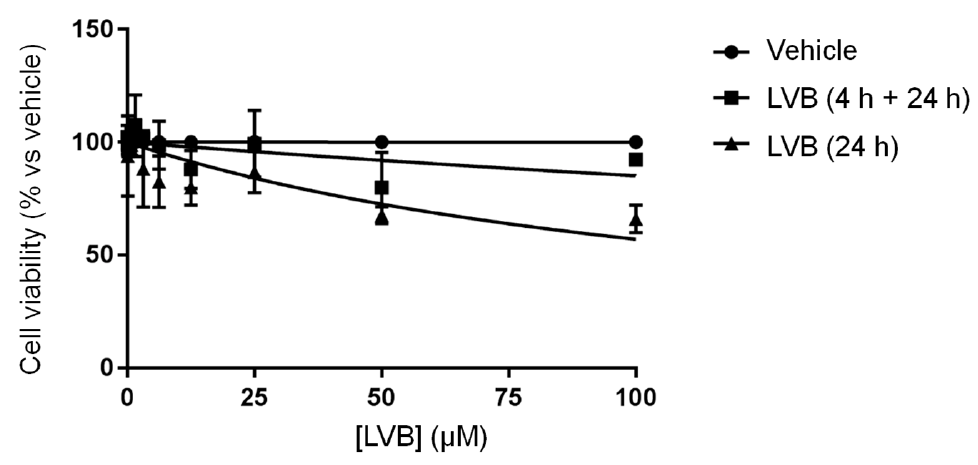
Figure 8. Viability of HEP-G2 hepatocarcinoma cells as a function of the concentration of free LVB. The biological activity of the ternary supramolecular assembly was tested under visible light excitation and in the dark and, for the sake of comparison, was compared to that of the binary complexes containing the individual either LVB or RD-NO under identical experimental conditions. These experiments were performed with LVB at a concentration of 50 µ M, which is well below the IC 50 , and RD-NO at a concentration of 6 µ M with irradiation not longer than 30 min, which allows generating NO only at moderately cytotoxic doses. The overall results are illustrated in Figure